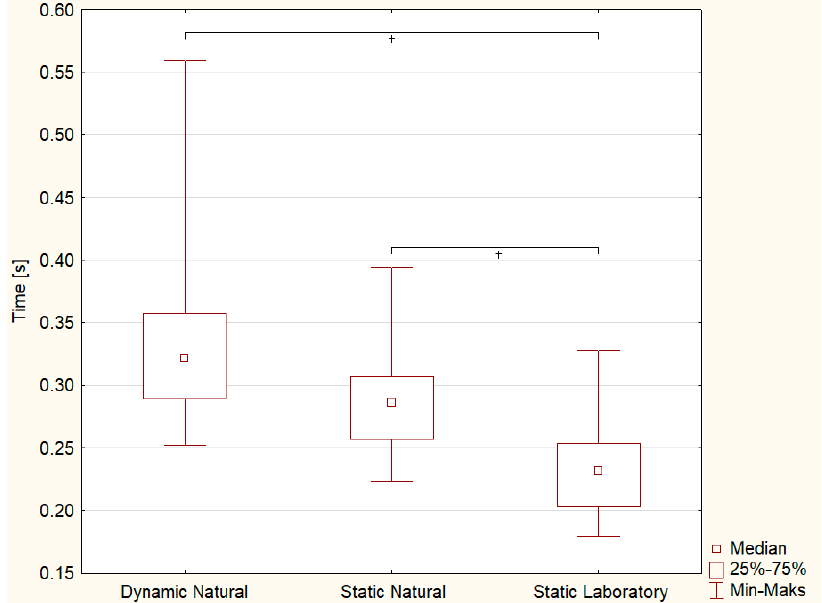
Figure 7. Box–whiskers plot of mean visual simple reaction time (s) under selected conditions in boys group (small box: median, box: first (25%) and third (75%) quartile, whiskers: minimum (Min) and maximum (Maks), cross (+): significant difference).